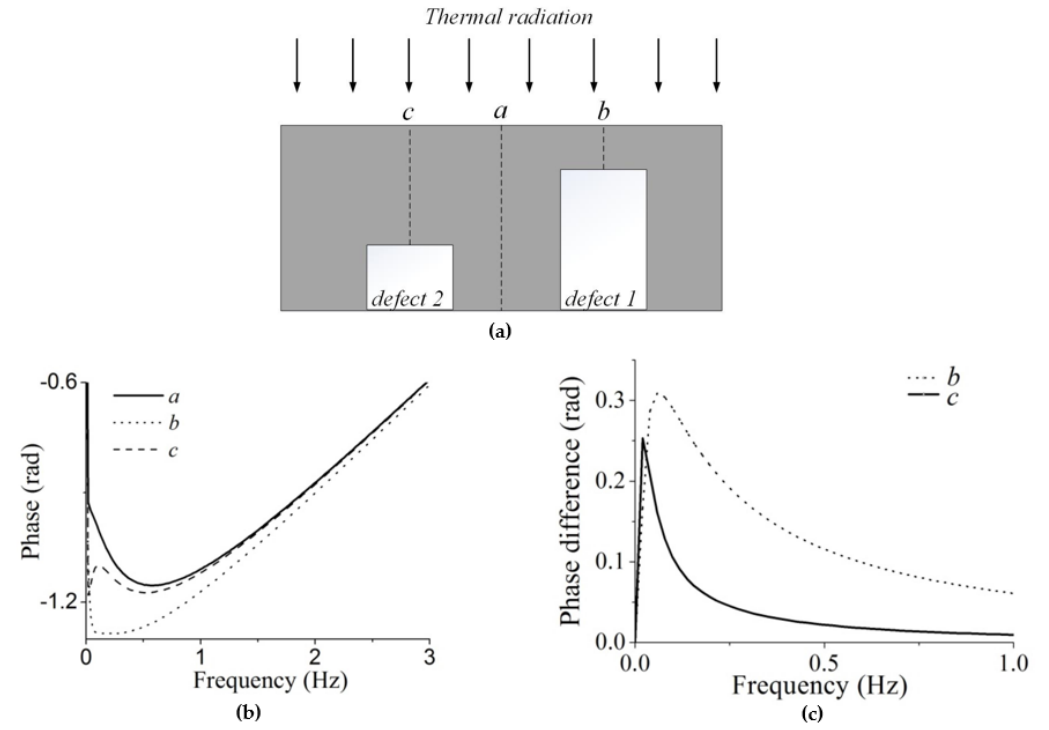
Figure 1. ( a ) Schematics of a panel with defects; ( b ) phase variation at locations with and without defects; ( c ) variation of phase difference corresponding to locations with defects.